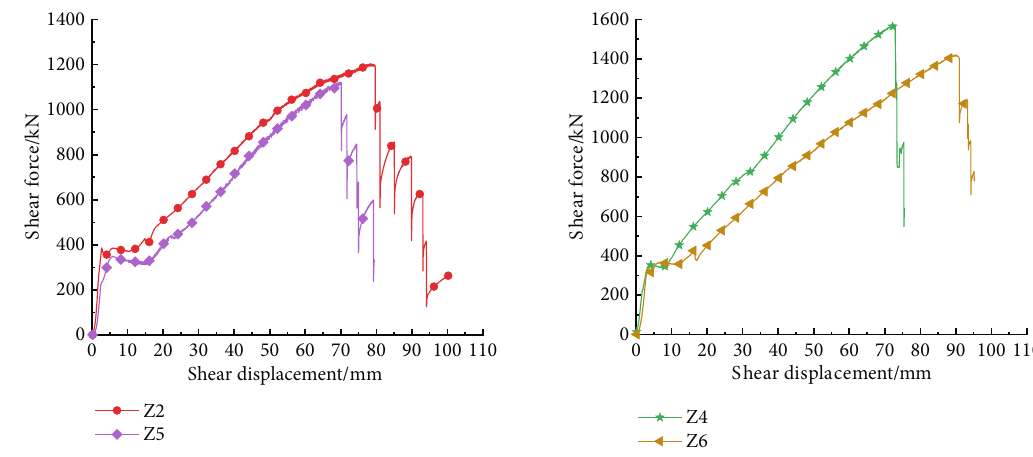
(b) Comparison of Φ 21.8mm ACC and Φ 21.8mm anchor cable Figure 12: Comparison of shear resistance of di ff erent supporting